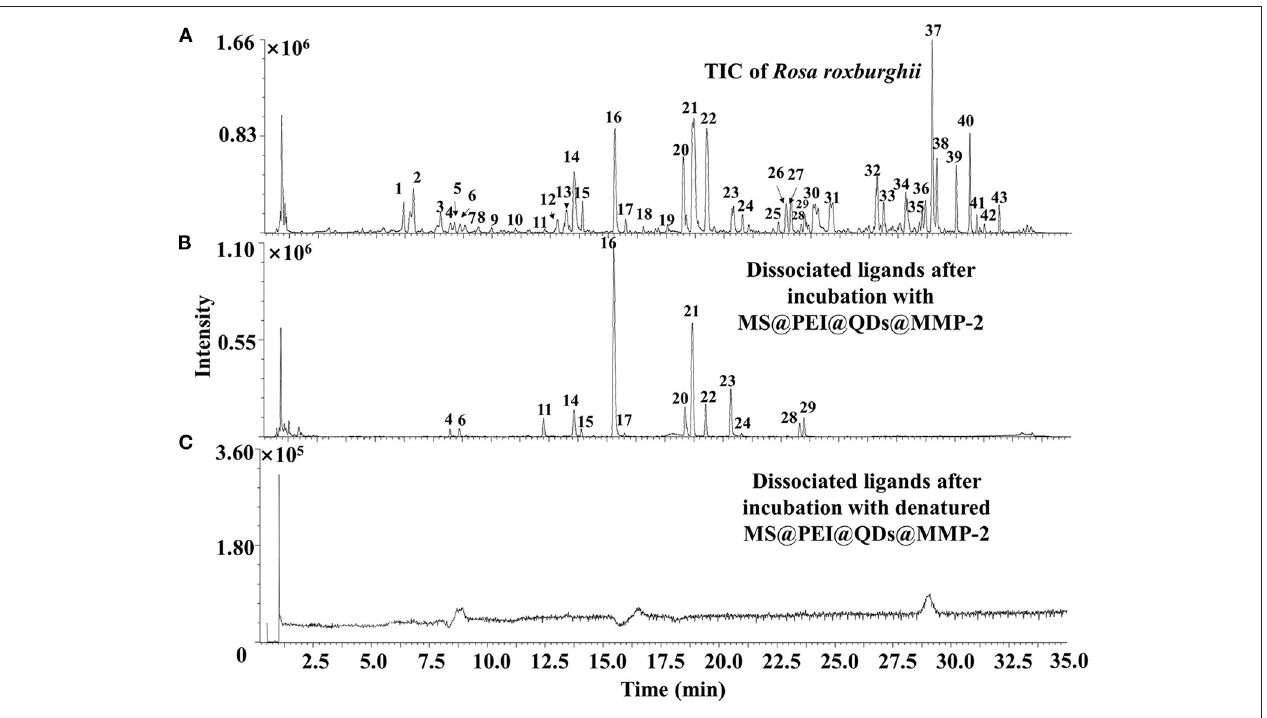
FIGURE 6 | TIC of (A) crude extract of Rosa roxburghii and (B) dissociated MMP-2 binding ligands after incubation with MS@PEI@QDs@PEI@MMP-2 or (C) denatured MS@PEI@QDs@PEI@MMP-2.